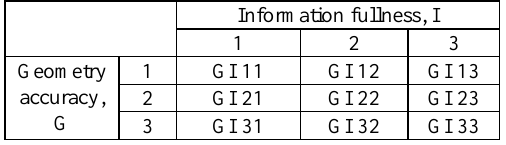
Table 1. Possible combinations of information fullness and geometry accuracy in scan-to BIM